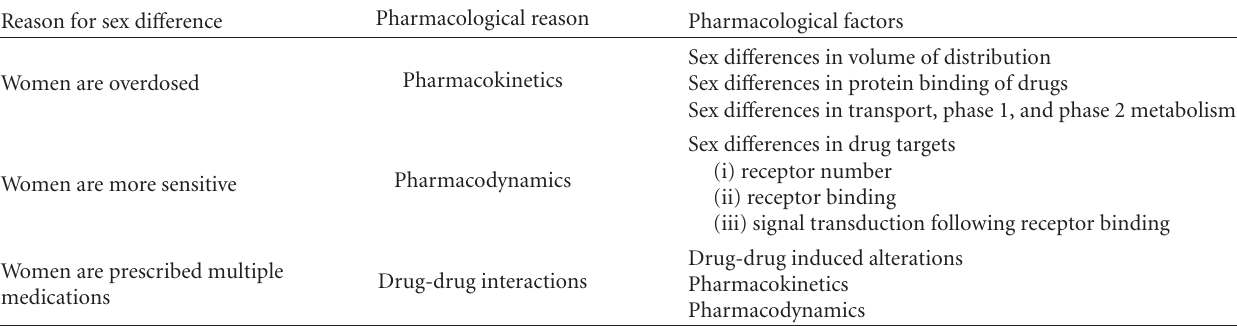
Table 1: Suggested reasons for sex di ff erences in adverse event